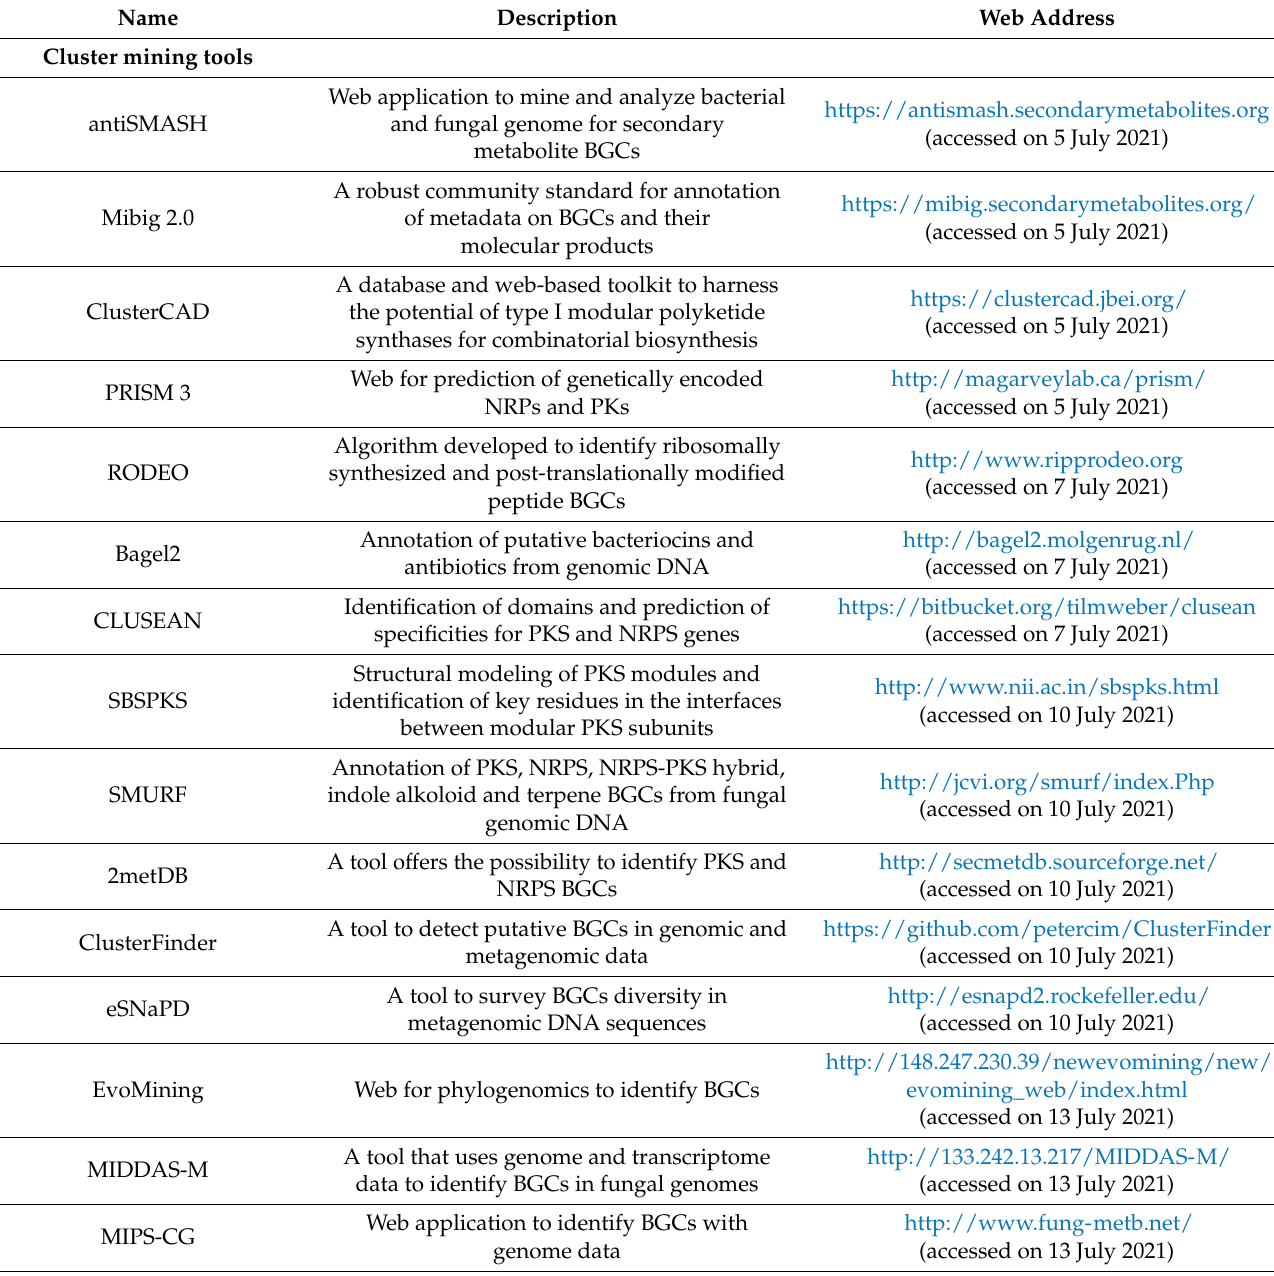
Table 1. Tools for natural product pathway discovery, prediction and